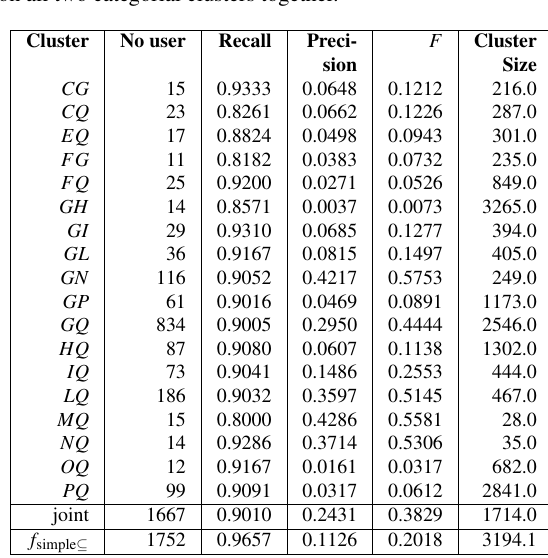
Table 7. Performance of classifier f t , t (cid:48) ∨ t (cid:48)(cid:48) for sequences with two categories. Last verse describes performance of classifier on all two categorial clusters